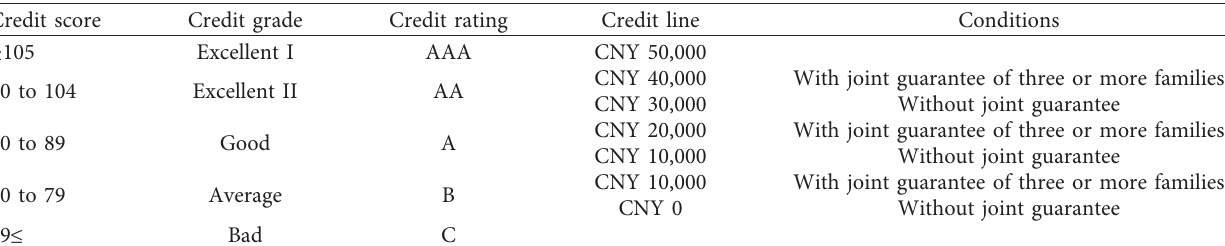
Table 4: The credit rating for farmers in A County in